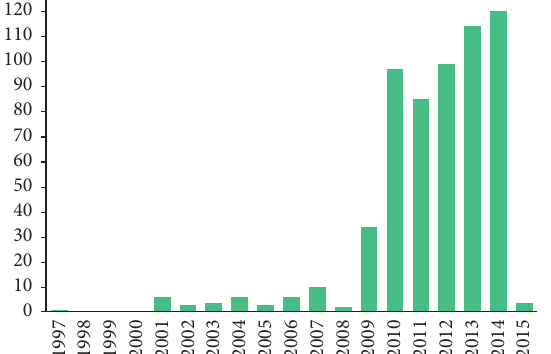
Figure 1: Number of citations of papers on hyporheic zone since 1997, based on a search in the ISI Web of Science (http://apps.webofknowledge.com/CitationReport.do?product=UA&search mode=CitationReport&SID=Z2Y7ku9pWciBC3oHJF3&page=1 &cr pqid=3&viewType=summary).